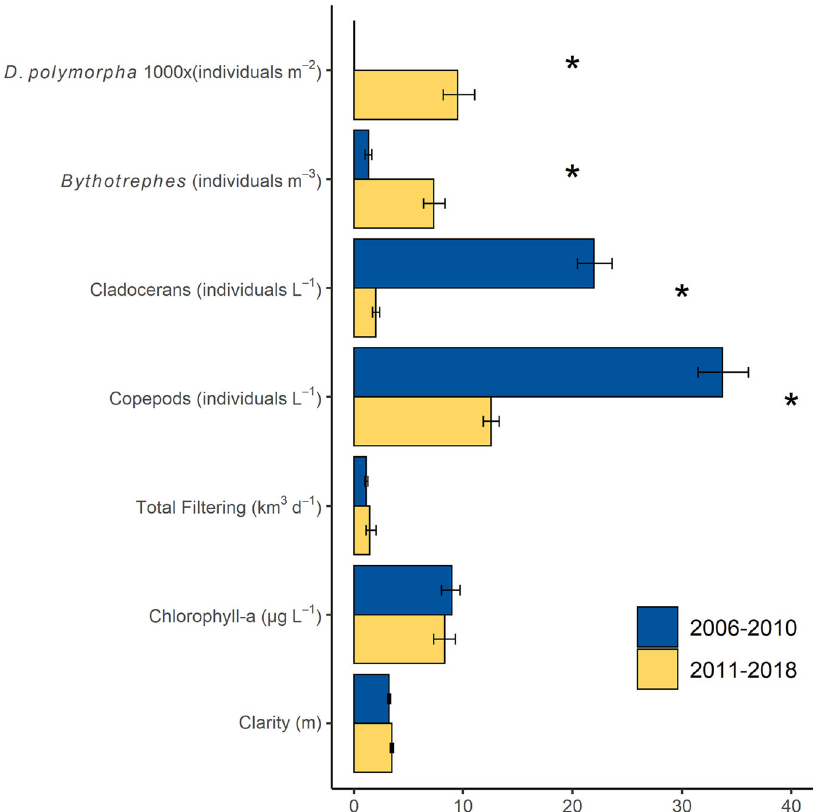
Fig. 6 Comparisons of community attributes and water clarity in Lake Mille Lacs related to invasion. Densities of two invasive invertebrates ( Dreissena , 1000 * individuals m – 2 , and Bythotrephes , individuals m – 3 ) before (2006 – 2010) and after (2011 – 2018) both populations expanded. The densities of native zooplankton (cladocerans and copepods, excluding Bythotrephes individuals L − 1 ) decreased in response to co-invasion, but total water column fi ltering (sum of herbivorous zooplankton and Dreissena fi ltering, km 3 d − 1 ) did not change. As a result, there was no change in median chlorophyll a ( μ g L − 1 ) or median water clarity (m) despite large food web perturbations. Bars are medians of bootstrapped estimates. Error bars represent the 95% C.I., and asterisks represent signi fi cant changes ( p < 0.05) to a